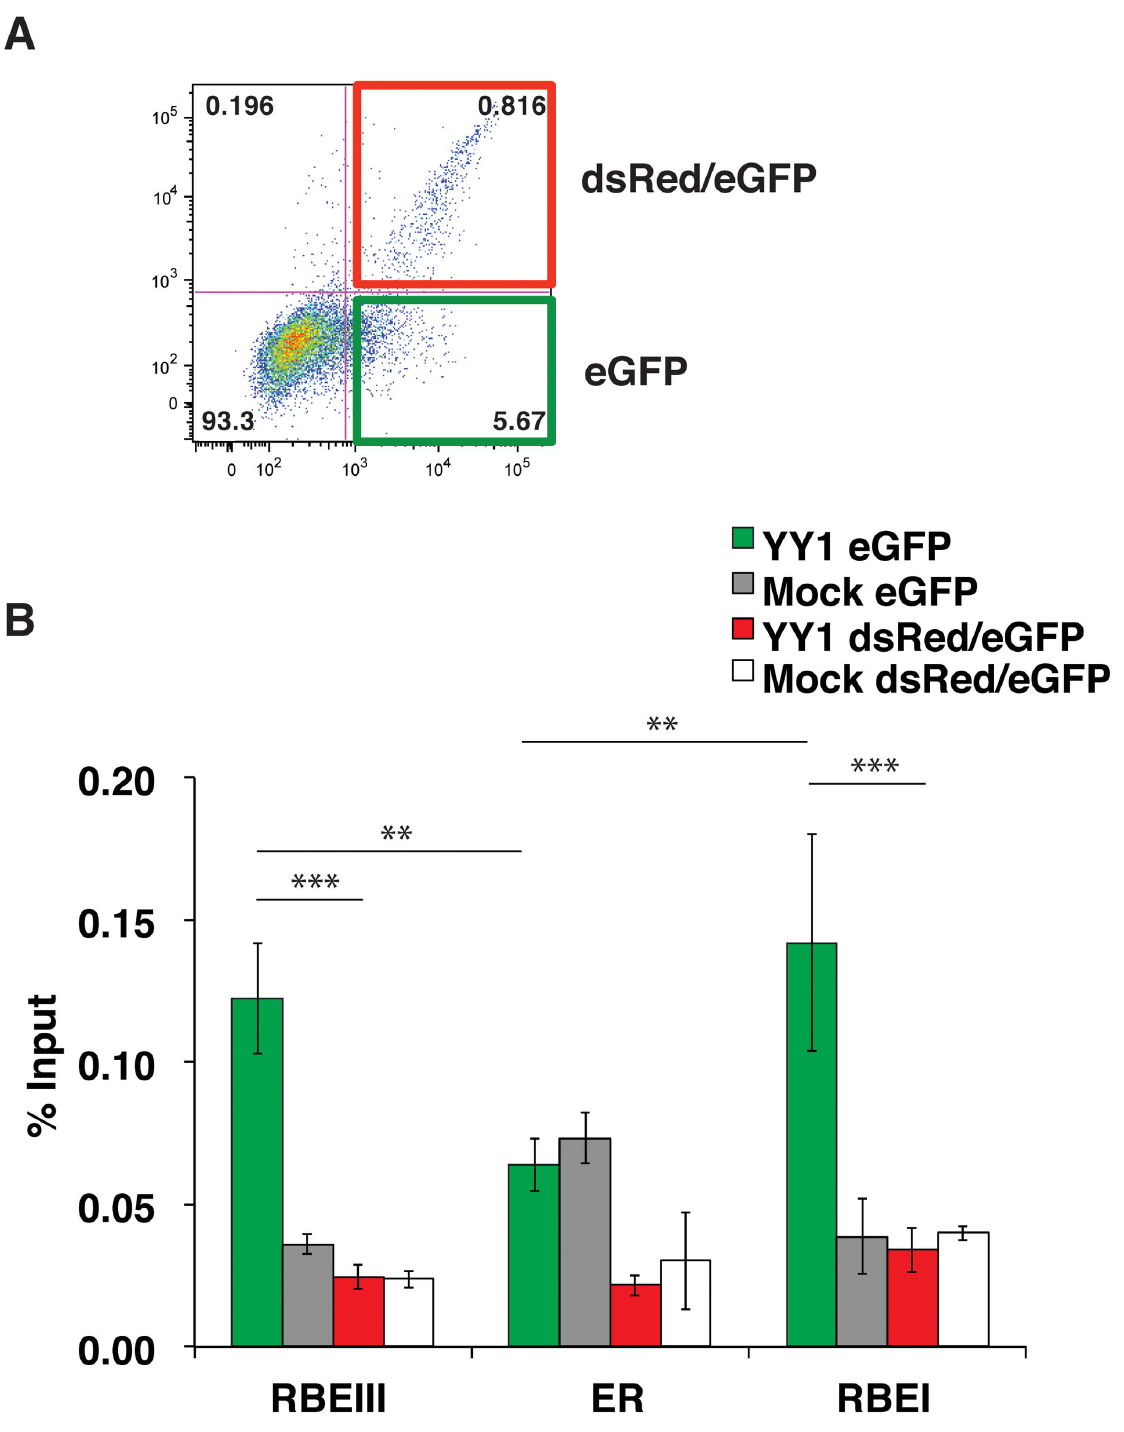
Figure 4. YY1 is not bound to actively transcribed HIV-1 LTR in unstimulated Jurkat-tat cells. Panel A : A representative population of Jurkat-tat cells infected with the wild type reporter virus was sorted using by FACS and populations of cells expressing only eGFP (green) or both eGFP and dsRed (red) were collected and expanded in culture. Panel B : ChIP analysis was performed on the expanded populations of Jurkat-tat cells expressing eGFP (green) or both eGFP and dsRed (red) using YY1 antibodies and the primer sets as described in Figure 2B. * Represents P values ≤ 0.05, ** represents P values ≤ 0.01, *** represents P values ≤ 0.001. doi: 10.1371/journal.pone.0077052.g004 PLOS ONE |